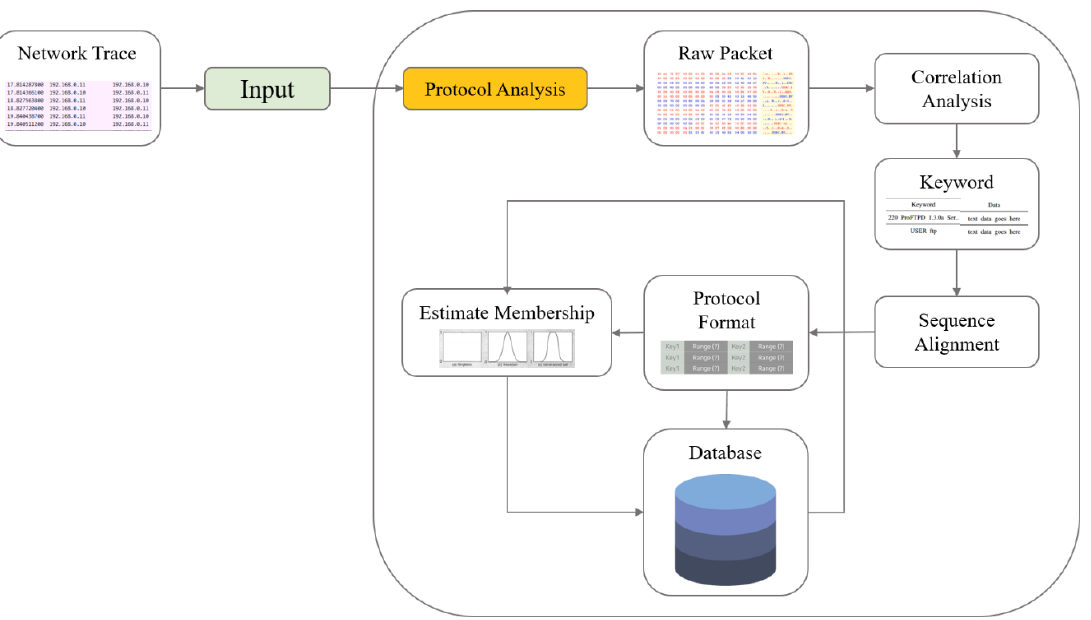
Figure 5. The figure above shows a method of grasping the characteristics of traffic during the traffic type recognition process to create a standard, and to enhance the membership function of the fuzzy set. This method has the advantage of quickly grasping the characteristics of new types and coping with them, and it is possible to respond appropriately through the flexibility of the fuzzy inference system even in the situation of little learning data, which is a weakness of learning